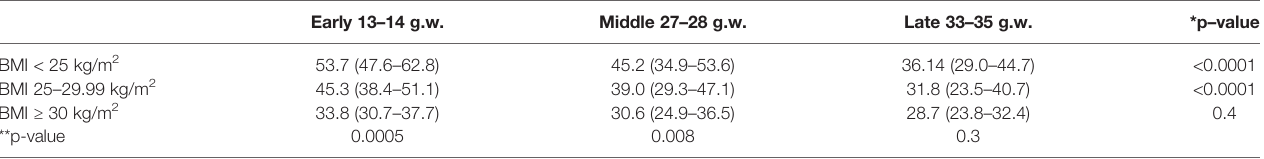
TABLE 6 | Correction Factor across early, middle, and late pregnancy, in each group and between